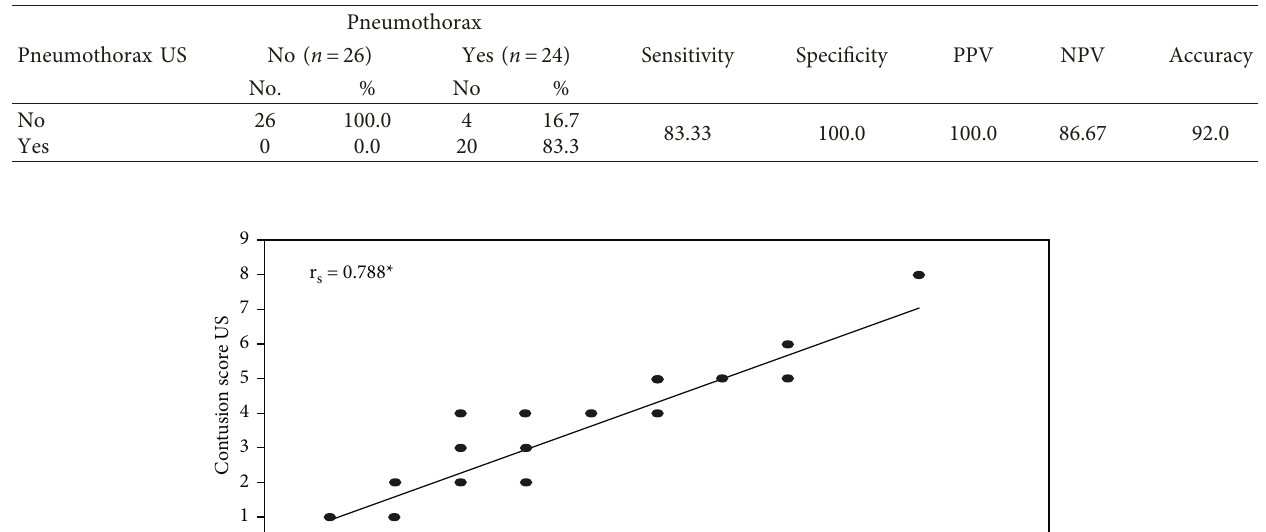
Table 2: Sensitivity, specificity, and accuracy for US pneumothorax diagnosis to CT.